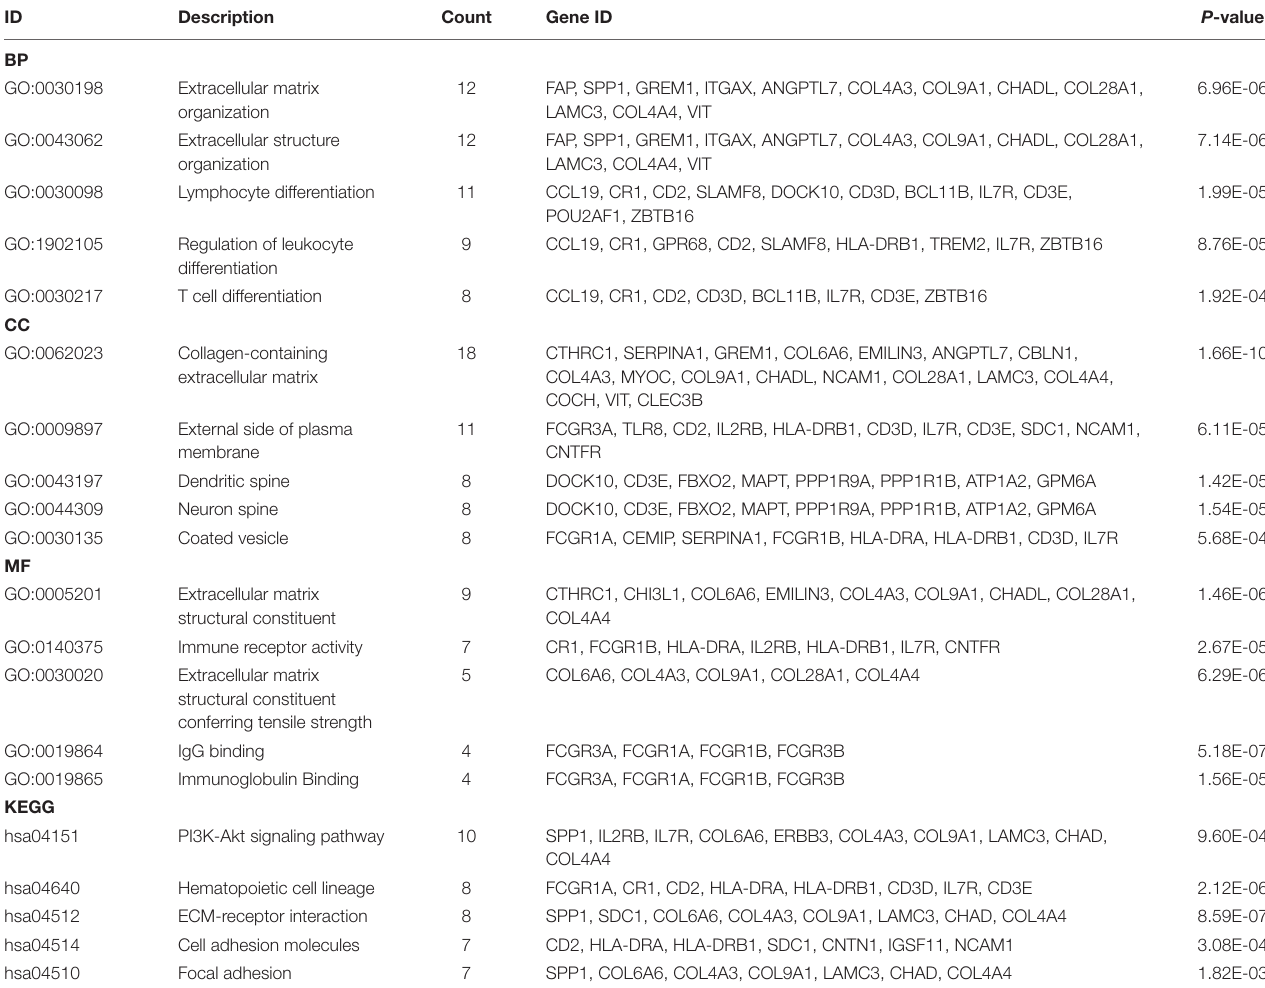
TABLE 2 | The GO and KEGG functional enrichment analyses of